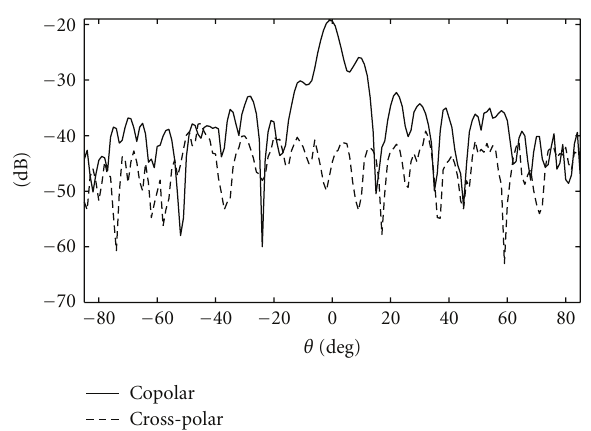
Figure 8: Measured radiation pattern (copolar and cross-polar components on x-z plane) for a main beam θ mb = 0 ◦ .